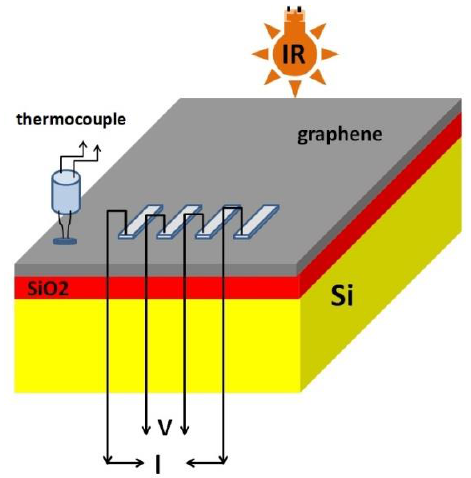
Figure 1. Schematic diagram of the experimental setup for the bolometric measurements. IR: infrared.